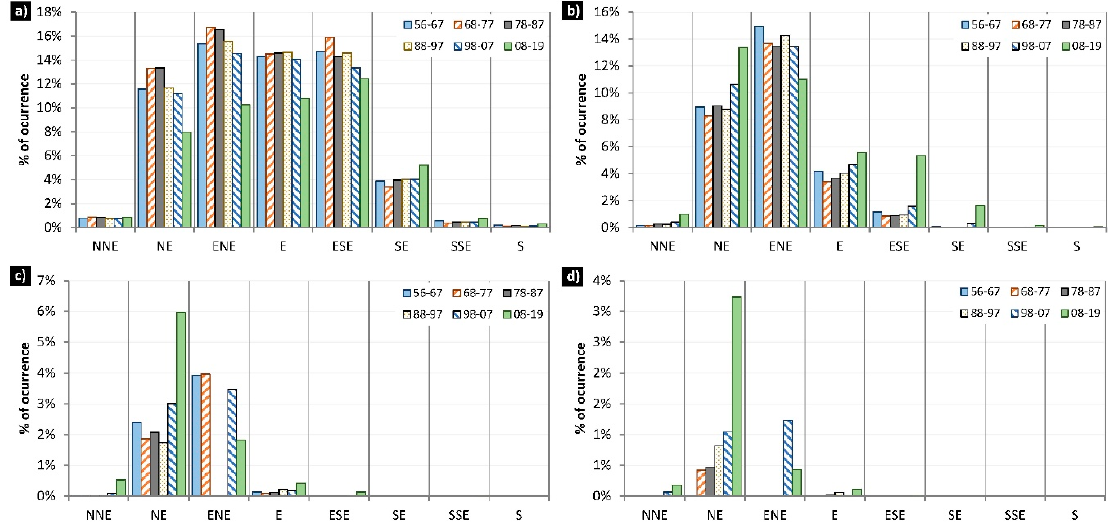
Figure 9. Percentage of occurrence of wave heights. ( a ) Wave height between 0 m and 0.5 m. ( b ) Wave height between 0.5 m and 1.0 m. ( c ) Wave height between 1.0 m and 1.5 m. ( d ) Wave height greater than 1.5 m.